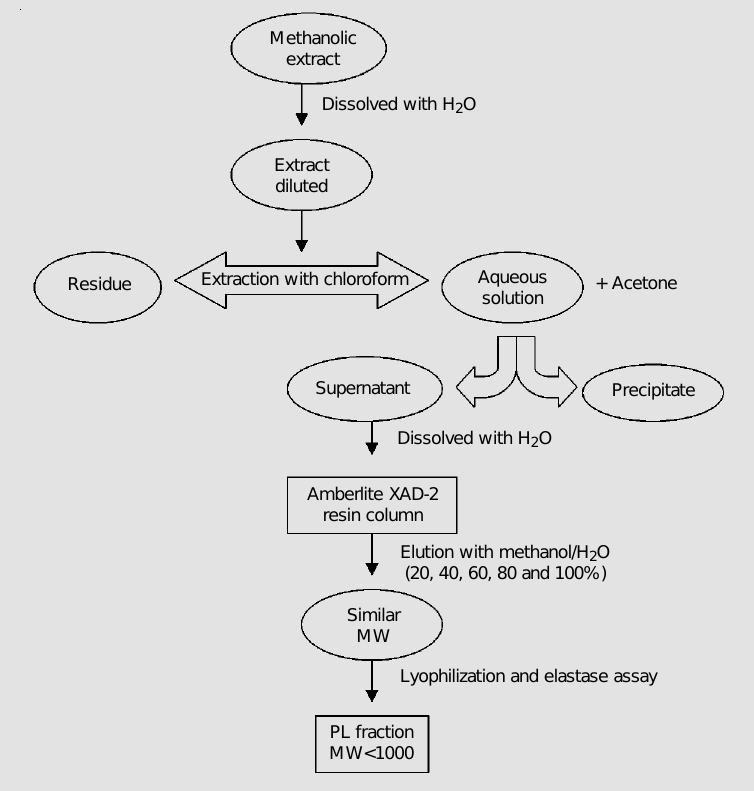
Figure 1. The Polypodium leucotomos extract (PL) obtained from Industrial Farmaceutica Cantabria S.A., Madrid, Spain, was treated as described by Tuominen et al.